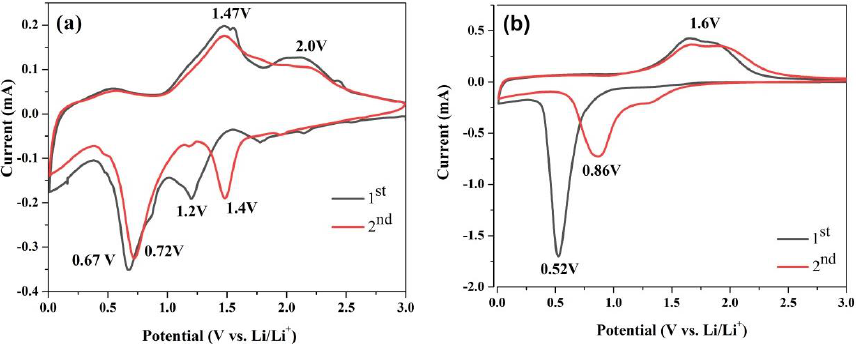
Figure 5. CV curves of the amorphous Fe 2 O 3 nanospheres A6h ( a ) and crystalline α -Fe 2 O 3 nano- spheres C1h ( b ).